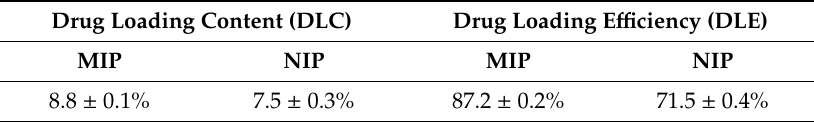
Table 6. Drug loading content (DLC) and drug loading e ffi ciency